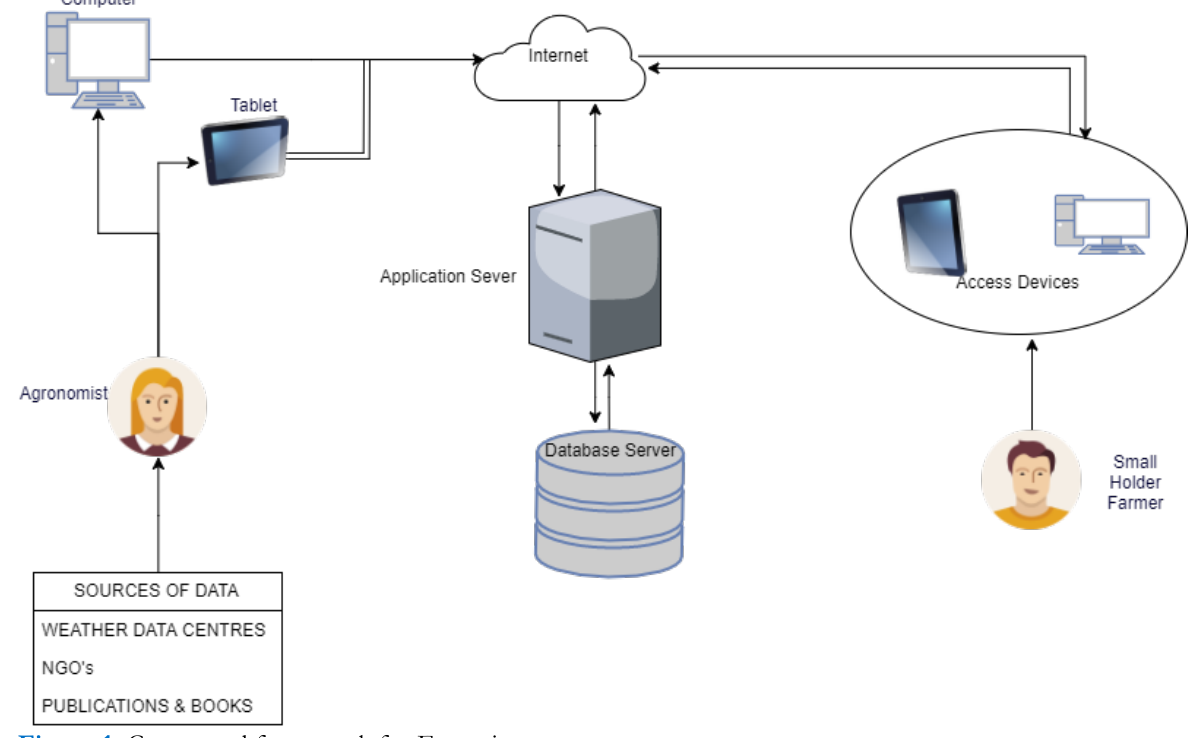
Figure 1. Conceptual framework for Extension support